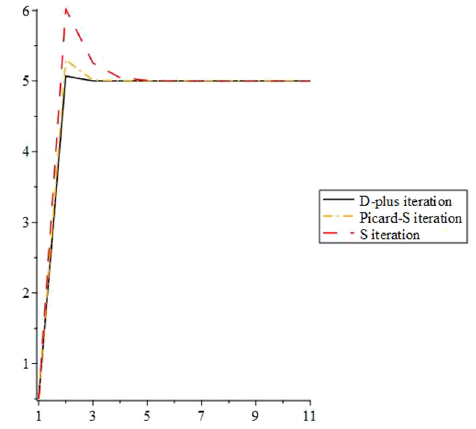
Figure 5: Convergence of D - plus, Picard - S and S - iteration processes in Example 1.